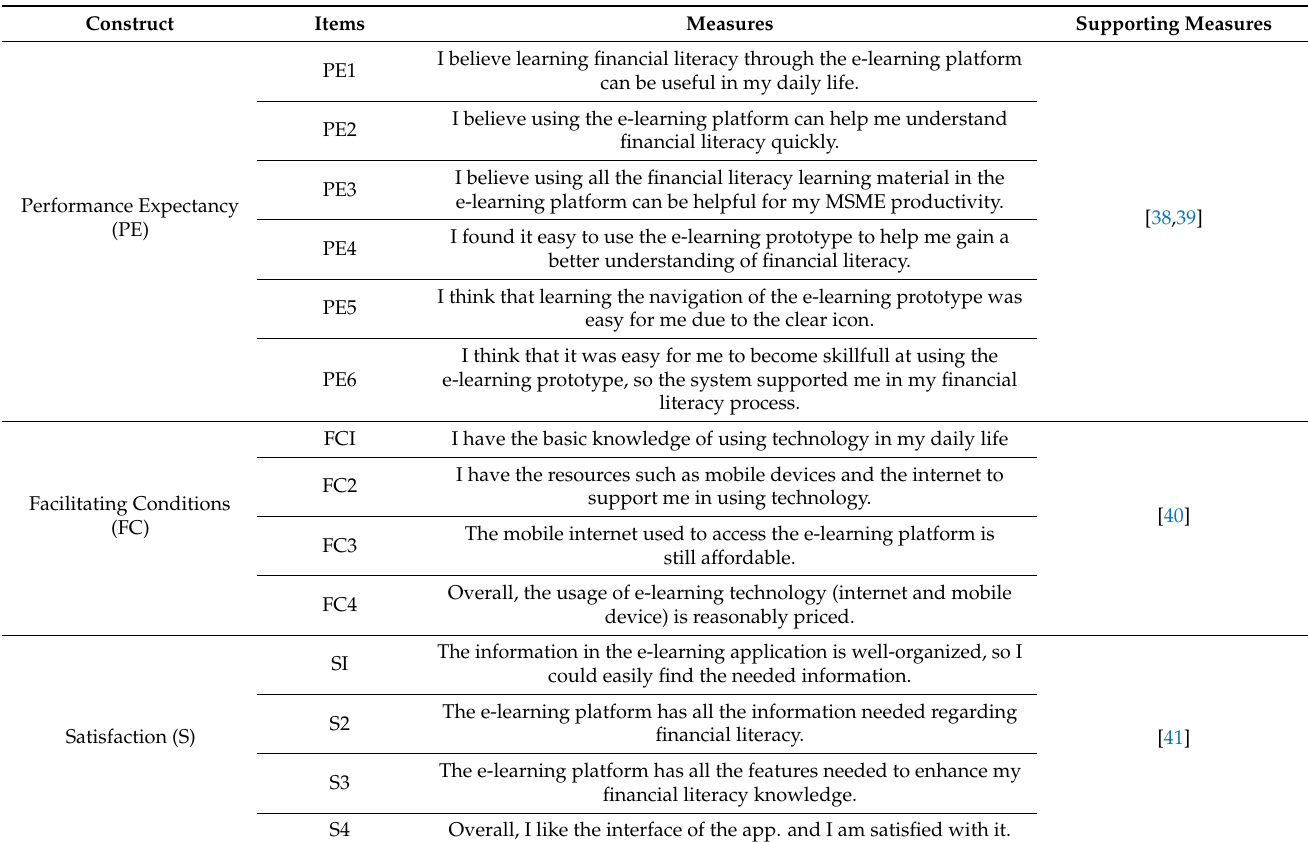
Table 1. The construct and measurement